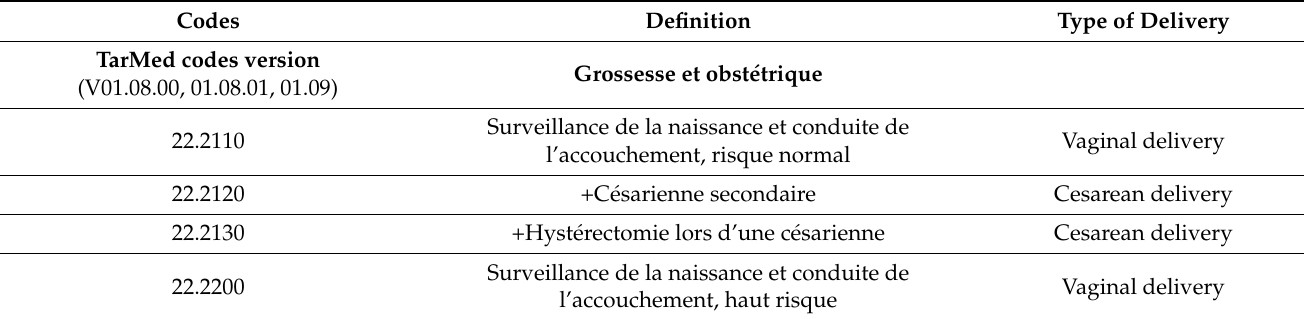
Table A1. Relevant codes to identify vaginal or caesarean